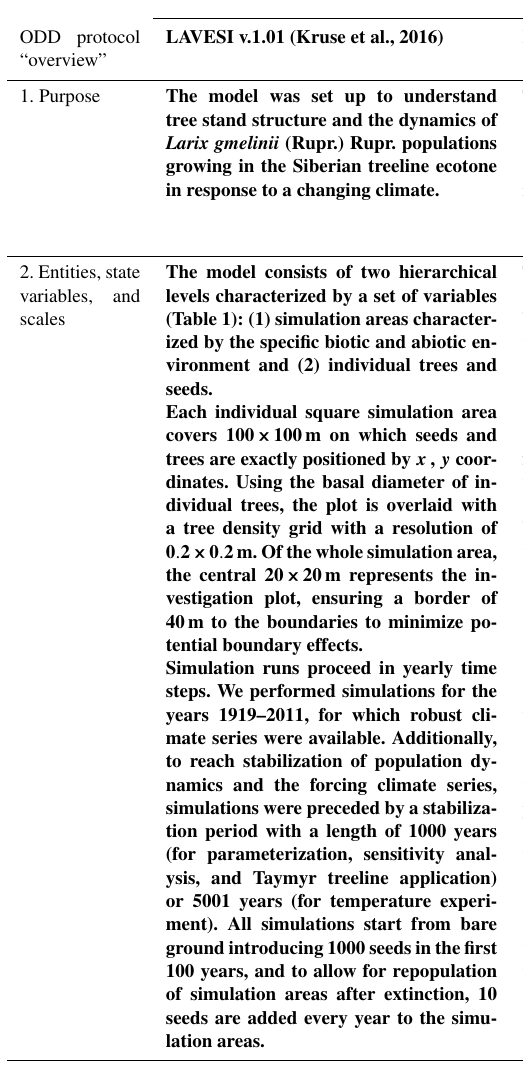
Table A1. Complete ODD “overview” table for LAVESI. Improvements from left to right; normal text represents unchanged model parts, while bold font highlights novel